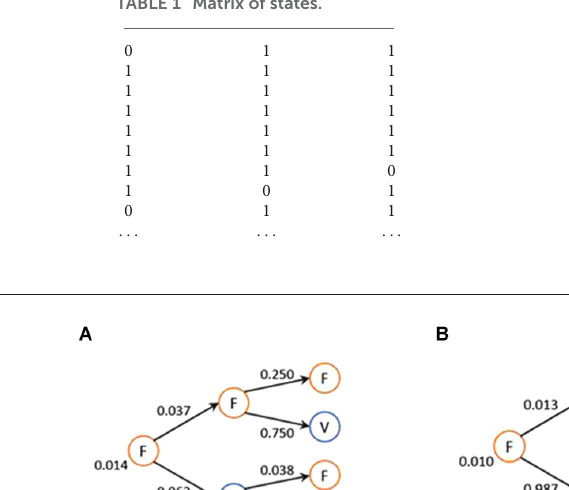
TABLE 1 Matrix of states.